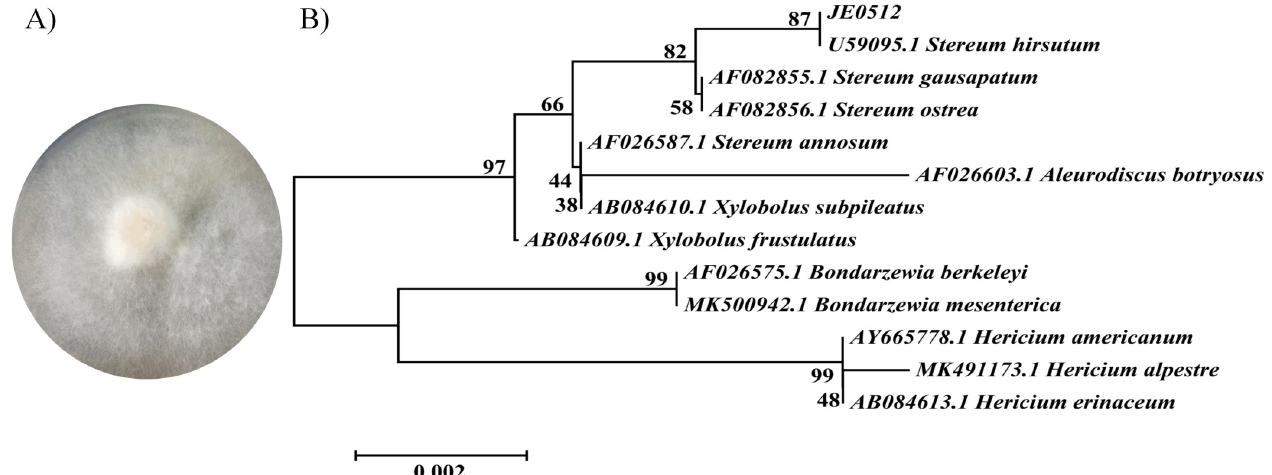
Fig 4. Identification of strain JE0512. A: Colony morphology of the isolate JE0512 grown at 25˚C on PDA. B: Phylogenetic analysis of the related species of the strain JE0512 using the neighbor-joining approach. The scale bars represent 0.002 substitutions per site. The tree was constructed using a neighbor-joining method with bootstrap values of 1000